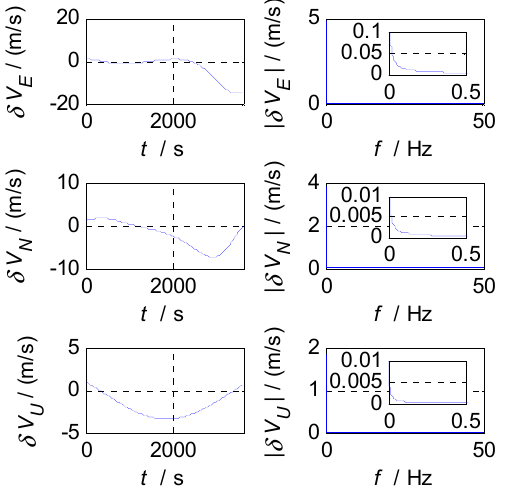
Figure 6. Velocity errors and frequency characteristics of GPS.